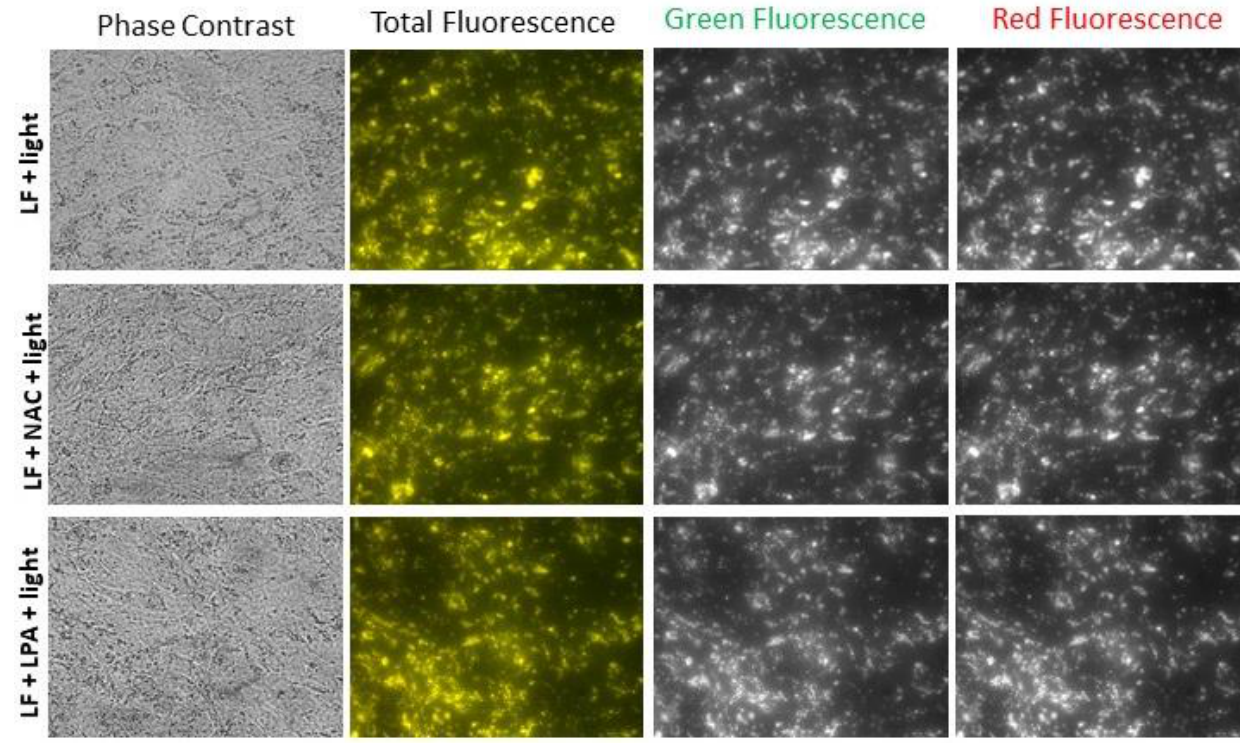
Figure 4. Supplementation with antioxidants of lipofuscin-laden ARPE-19 cells during 14 daily exposures to 9.76 mJ/cm 2 visible light does not affect loss of lipofuscin granules or spectral changes in fluorescence. Representative images from phase-contrast and fluorescence microscopy of lipofuscin-laden ARPE-19 cells after 14 daily exposures to visible light in the absence (LF + 14 × Light) and presence of N-acetyl cysteine (NAC) or lipoic acid (LPA). Other experimental conditions as in Figure 3.